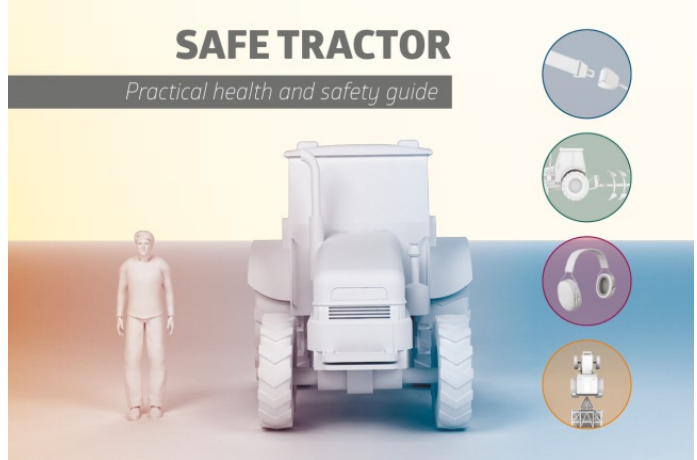
Figure 8. The cover with the four colours of the different sections included.